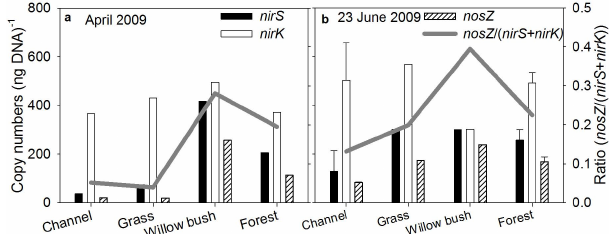
Fig. 7. Abundance of the functional genes nirS , nirK , and nosZ in April 2009 (a) and 23 June 2009 (b) in the different riparian zones. The potential of the denitrifying community to carry out complete denitrification (from NO − to N 2 ) is indicated by the ra- 3 tio of nosZ /( nirS+nirK ). Values from piezometers located in the same zone were averaged and error bars represent standard devia- tions ( n > 2) or average deviations ( n = 2).